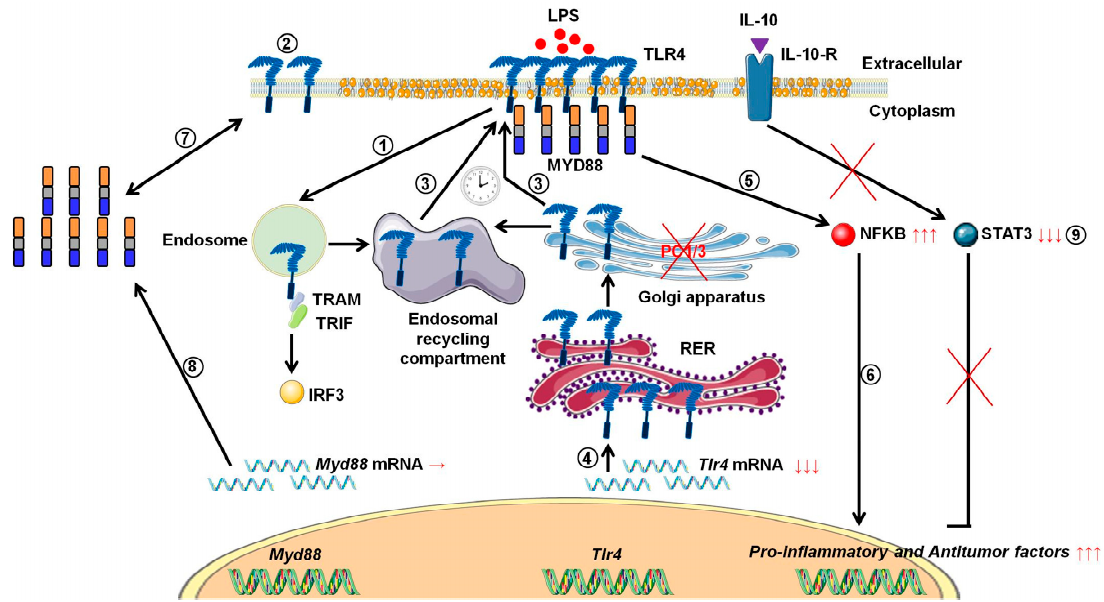
Figure 10. Proposed model depicting the impact of PC1/3 knockdown on the activation of TLR4. Yellow droplets in the cell membrane symbolize that KD cells exhibited modifications of their lipid profile. ( 1 ) After LPS treatment, TLR4 is internalized in the endosomes to trigger the